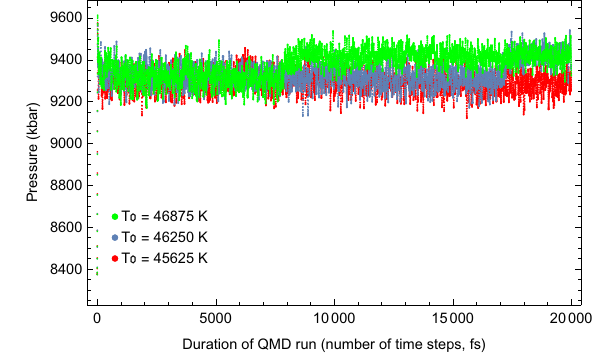
Figure 15. The same as in Figure 2 for